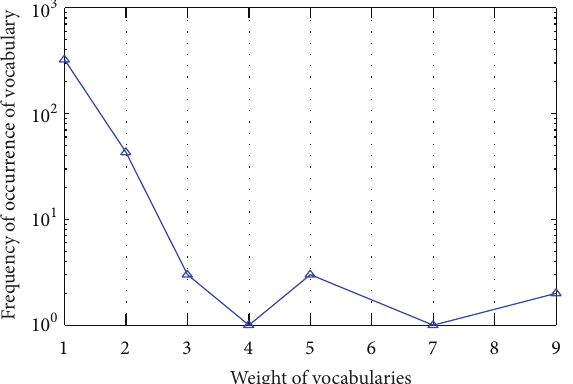
Figure 5: Relationship between weight of vocabularies and frequen- cies of weight of